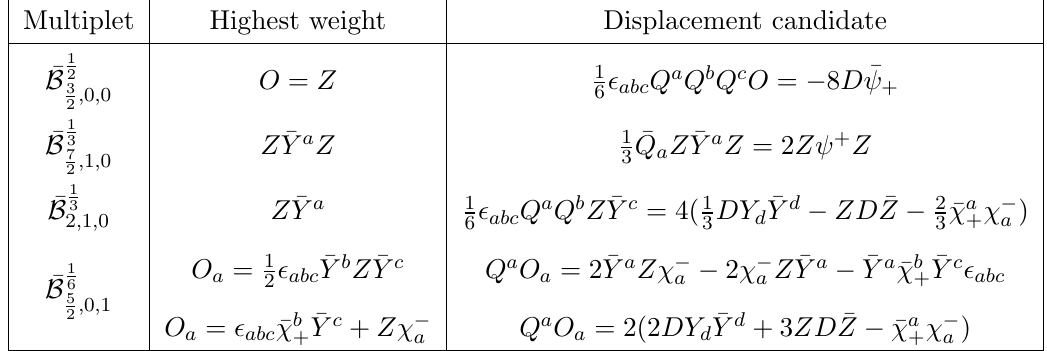
Table 2 . The possible multiplets containing the displacement operator. We apply the appropriate supercharges (according to section C.2) to the highest weight operator and we project the result on the R-symmetry singlet